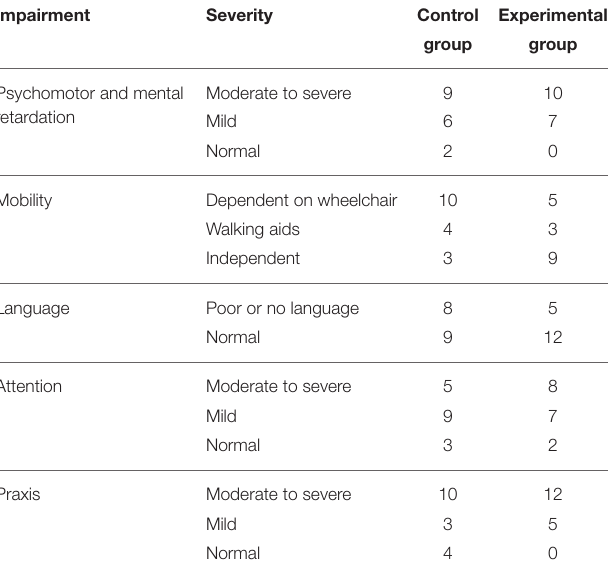
TABLE 2 | Summary of deficits of the samples.